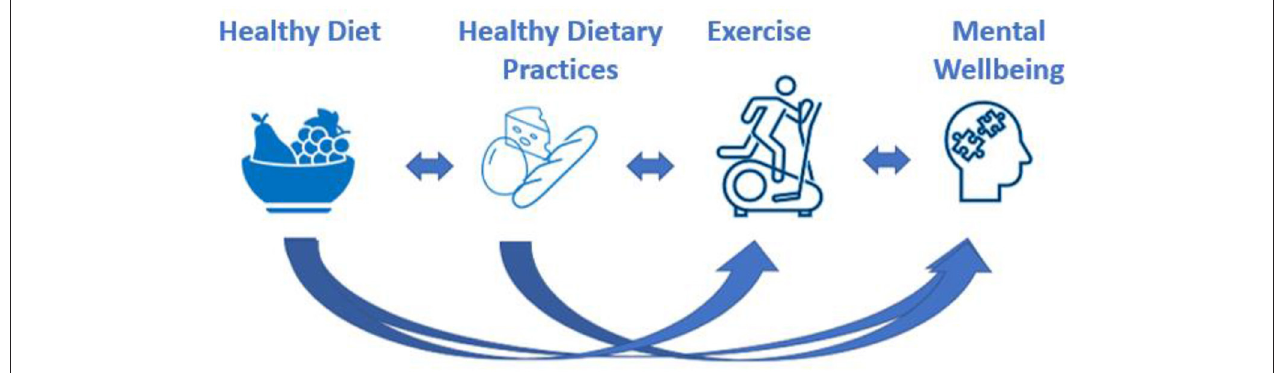
FIGURE 1 | Graphical representation of the hypothetical model. The arrows represent positive impact. Diet impacts exercise and mental well-being. Dietary practices impact exercise and mental well-being. Each component of the model has a reversal relationship with its neighboring component resulting in mental well-being improving diet quality and dietary